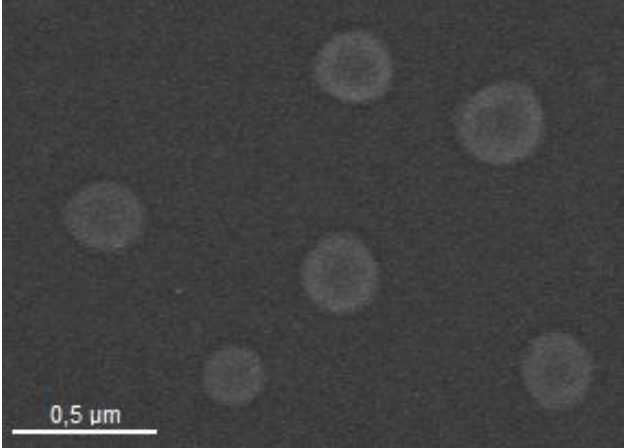
Figure 1. Transmission electron microscopy photography of the EPI